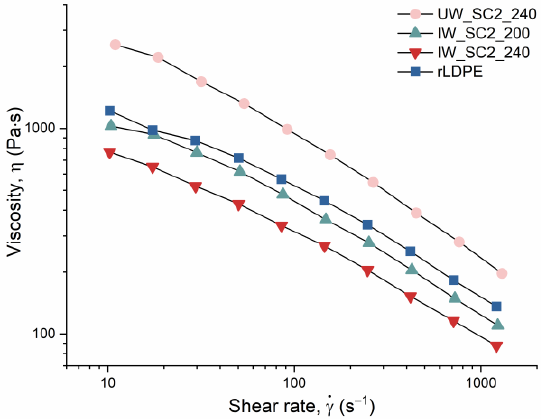
Figure 4. Viscosity as a function of shear rate for the unwashed, industrially washed, and recycled pellets.